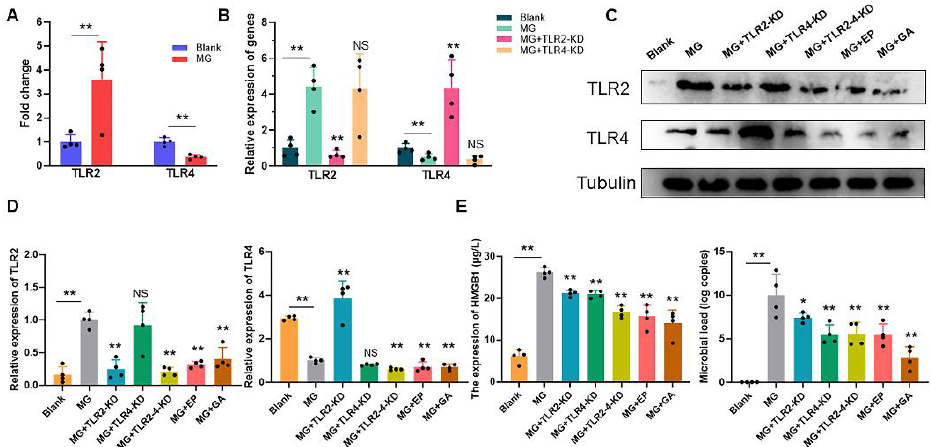
Figure 3. HMGB1 promotes MG infection via TLRs. ( A – D ) HD-11 cells were infected with MG for 24 h and cells were collected. The TLRs levels were detected by qPCR or WB. ( E ) Left : HMGB1 levels in the supernatant were measured by HMGB1 Elisa kit. Right : The MG colonization in HD-11 cells was detected. The data are the mean ± S.D. of at least four independent experiments. NS p > 0.05, * p < 0.05, and ** p < 0.01 show statistically significant difference compared to the MG group. Black dots in bar graph represent datasets from independent